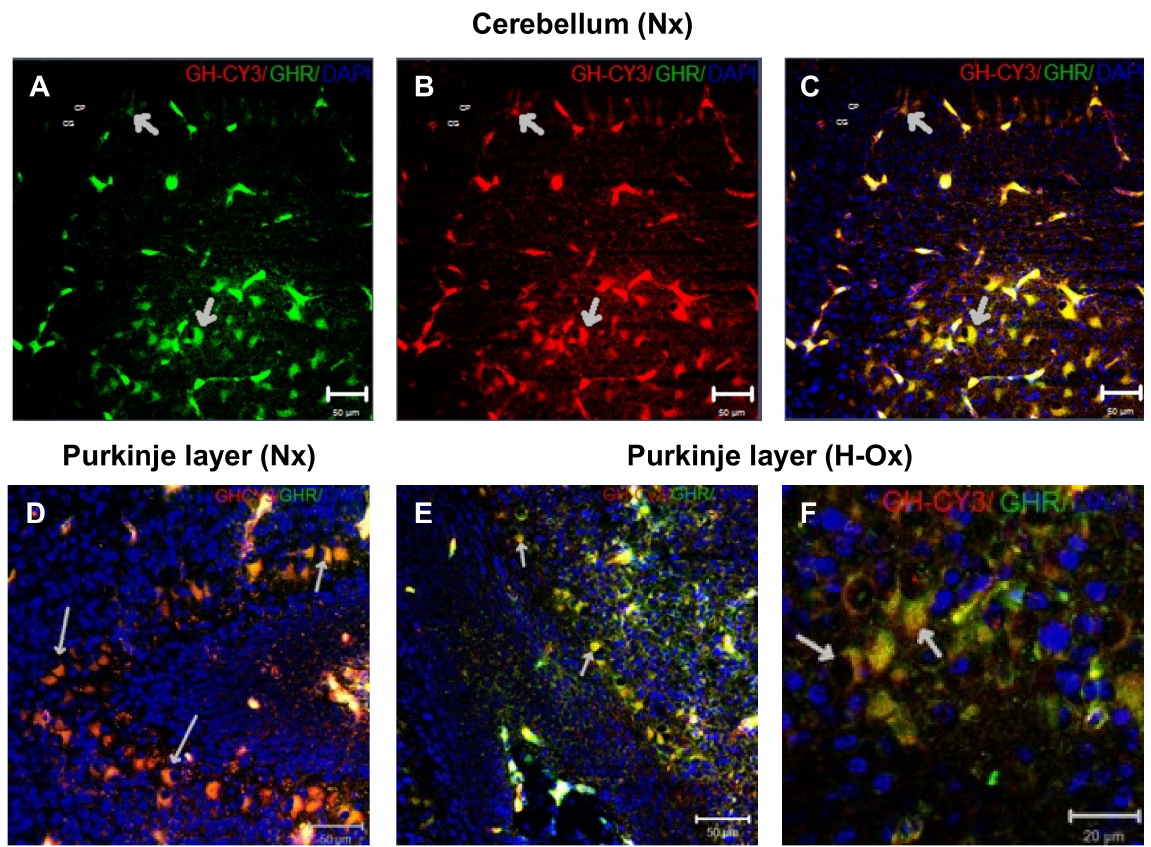
Figure 5. Co-localization of Cy3-GH and GH receptor (GHR)-immunoreactivity in the cerebel- lum. Representative immunohistochemical images showing the distribution of ( A ) GHR-IR (green), ( B ) Cy3-GH (red), or ( C ) merge of both (yellow) in the cerebellar deep nuclei and in the Purkinje cell layer ( D – F ) of embryos that were treated with Cy3-GH under either normoxic ( D ) or hypoxic ( E , F ) conditions. The yellow regions, indicated by arrows, show the co-localization of the hormone with its receptor. Cell nuclei were stained with DAPI (blue). Scale bar 20 µ m in ( F ); 50 µ m in ( A – E